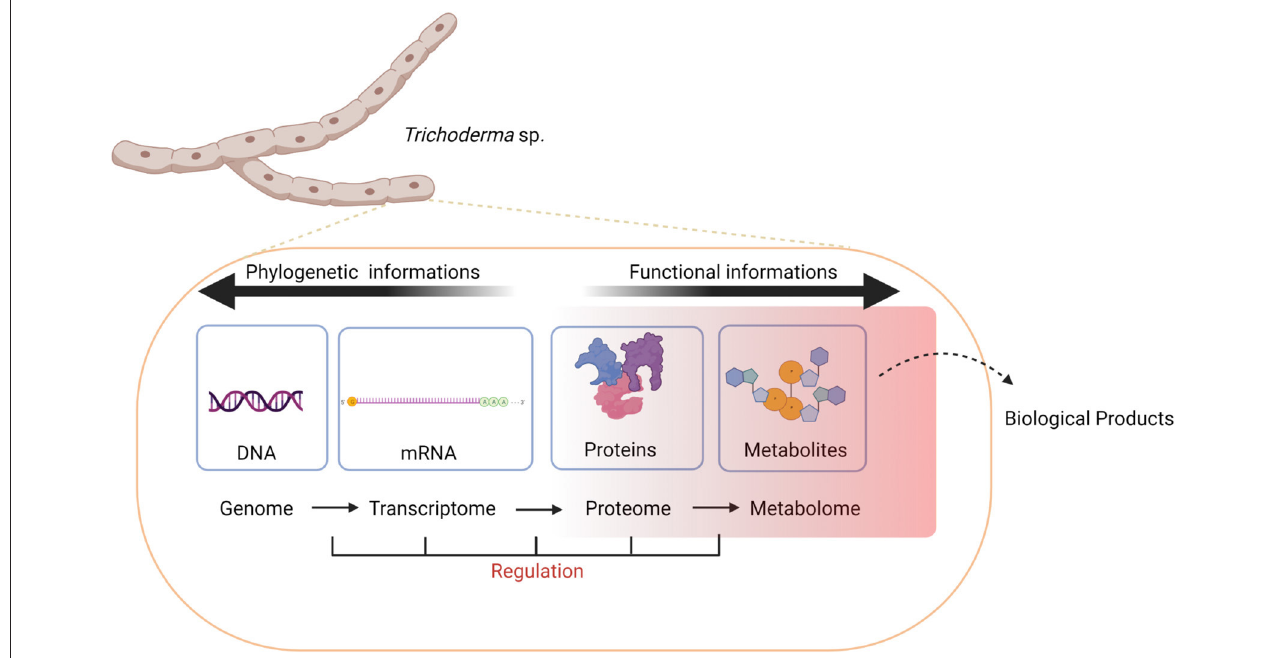
FIGURE 4 | Natural products are the result of layers of regulation transcending the genome, transcriptome, proteome, and metabolome levels that are altered in response to changes in endogenous or environmental cues.